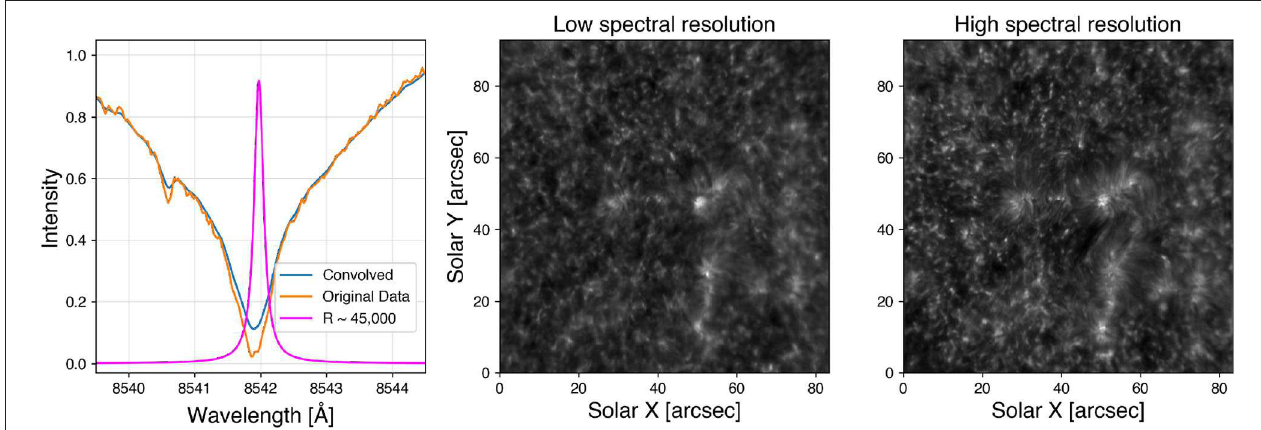
FIGURE 1 | (Left) Comparison of a sample line profile of the Ca II 8,542 Å line from the FISS dataset described in section 3 before (orange) and after (blue) convolution with the sPSF (magenta); The magenta curve is the transmission profile used for convolving the orange profile to get the blue one (corresponding to FP 2 of IBIS with R ∼ 45,000); (Center and Right) Comparison of chromospheric quiet Sun region observed with IBIS with low spectral resolution (R ∼ 50,000) on the central panel and with high spectral resolution (R ∼ 200,000) in the right panel. was accomplished in about 1,000 epochs with the relative RMS error at the last epoch of the training reaching about 1.5 × 10 − 4